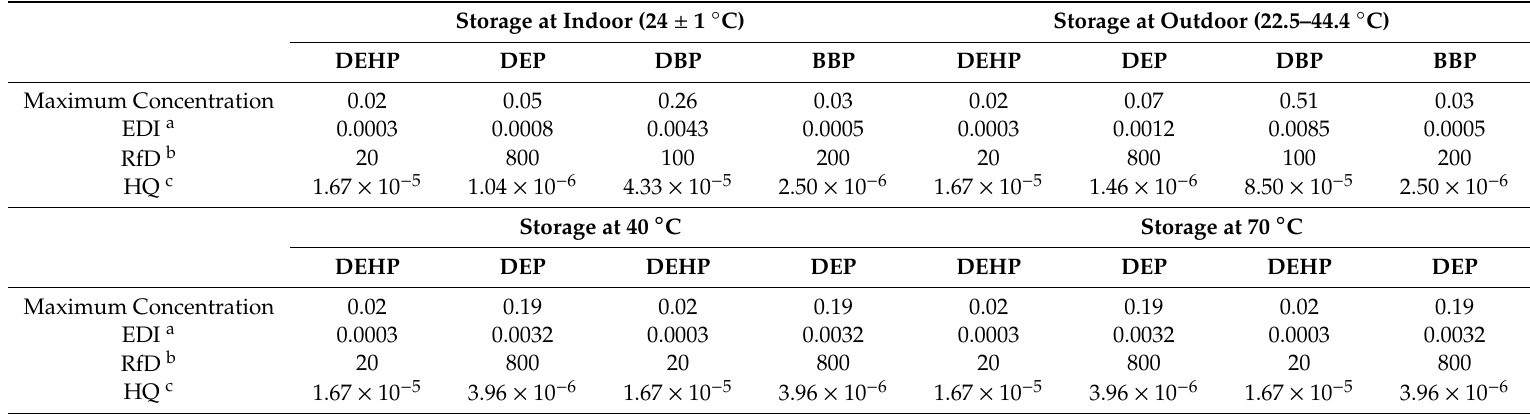
Table 3. Health risk assessment of PAEs ( µ g / L) for adults via consumption of PET bottled waters stored under typical